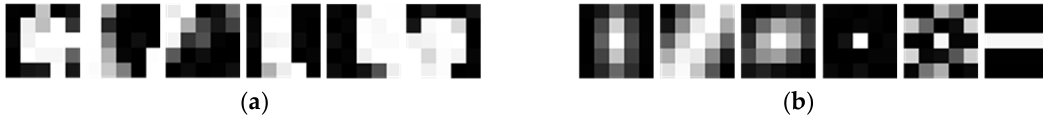
Figure 8. Fast training method for Gabor CNNs. The basic operation of FTM consists of two stages: (1) optimization of Gabor convolutional kernels with a few samples and evaluation structure; and (2) training other Gabor CNNs parameters with all samples. Gabor kernels can effectively express common features (like edges and texture) with simple optimization. Hence, we propose MPGA optimization with fewer iterations for the Gabor convolutional layer instead of training with a fixed learning rate. The Gabor features of the samples